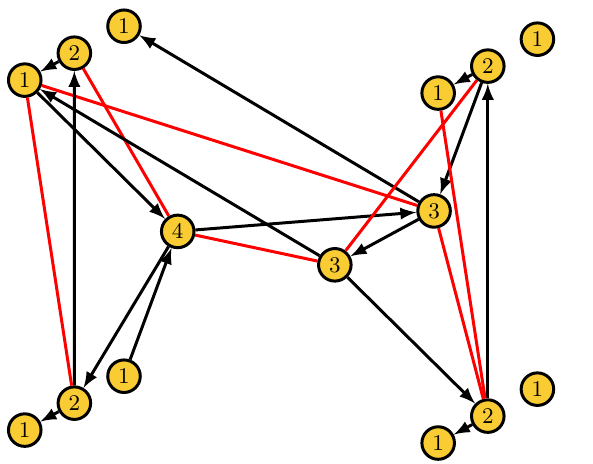
Figure 22. Periodic quiver obtained by performing a triality transformation on node 4 of (cid:12)gure 21.